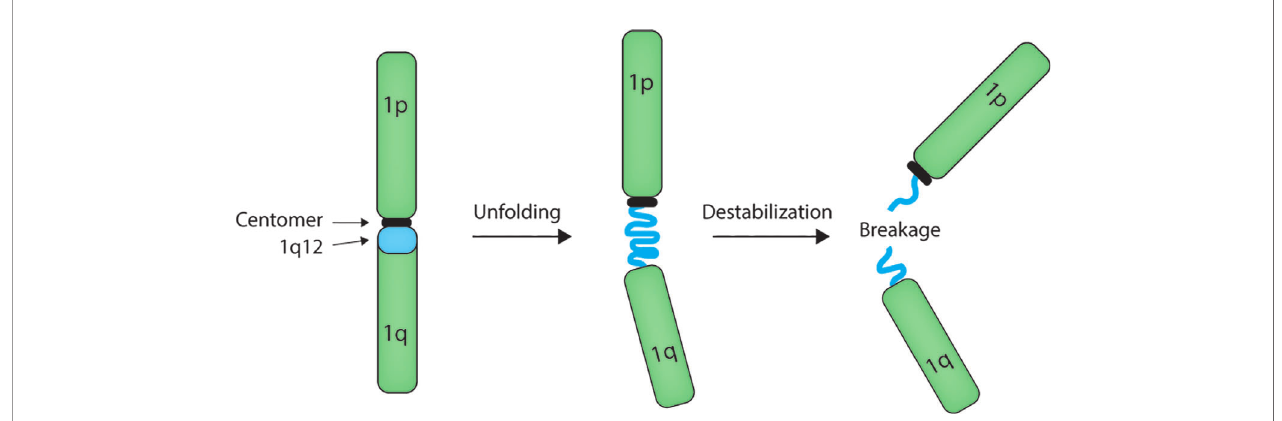
FIGURE 1 | Model for 1q12 pericentromeric heterochromatin involvement in rearrangement of the 1q arm. The megabase 1q12 pericentromeric heterochromatin is composed of satellite II and III DNA repeats. In multiple types of cancer, this domain unfolds and becomes instable, leading to rearrangement and ampli fi cation of the 1q